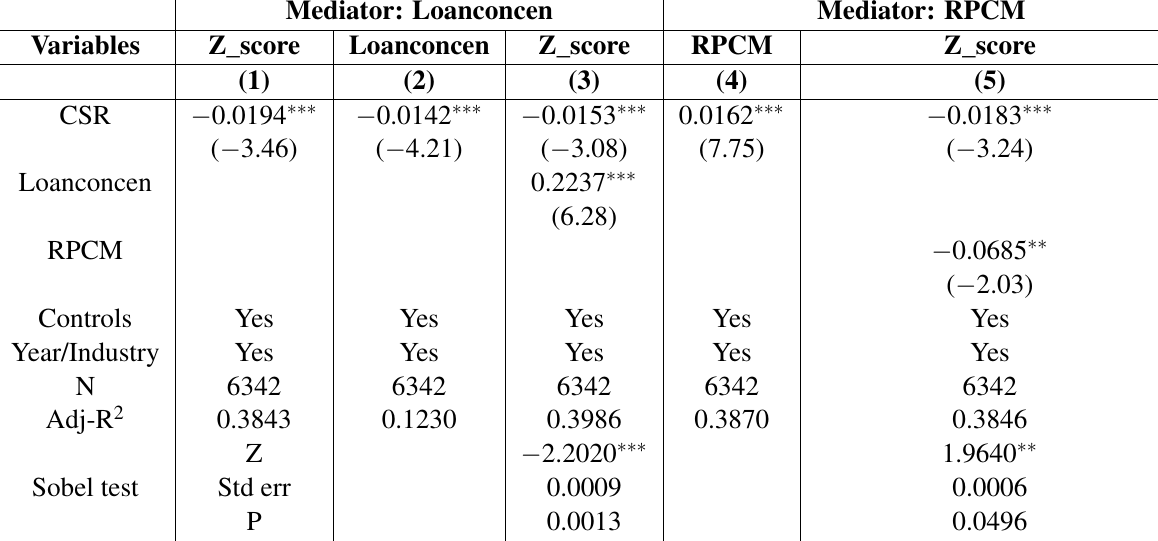
Table 10 Sample of firms registered in the central and western